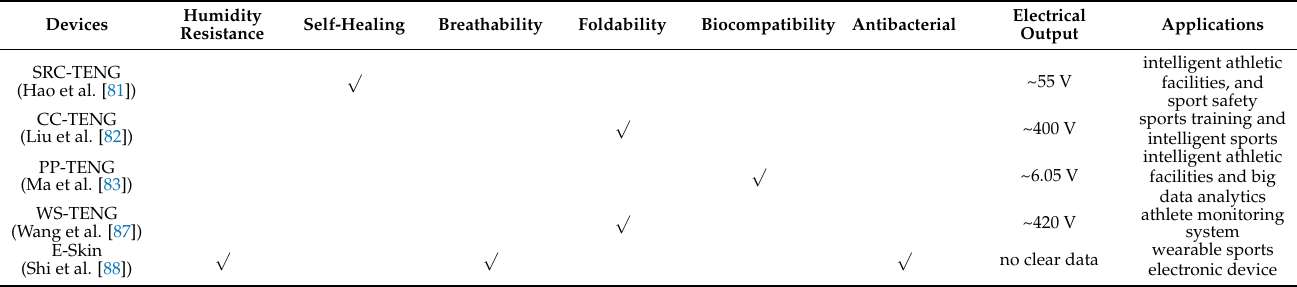
Table 2. Features and application comparison of different TENGs in